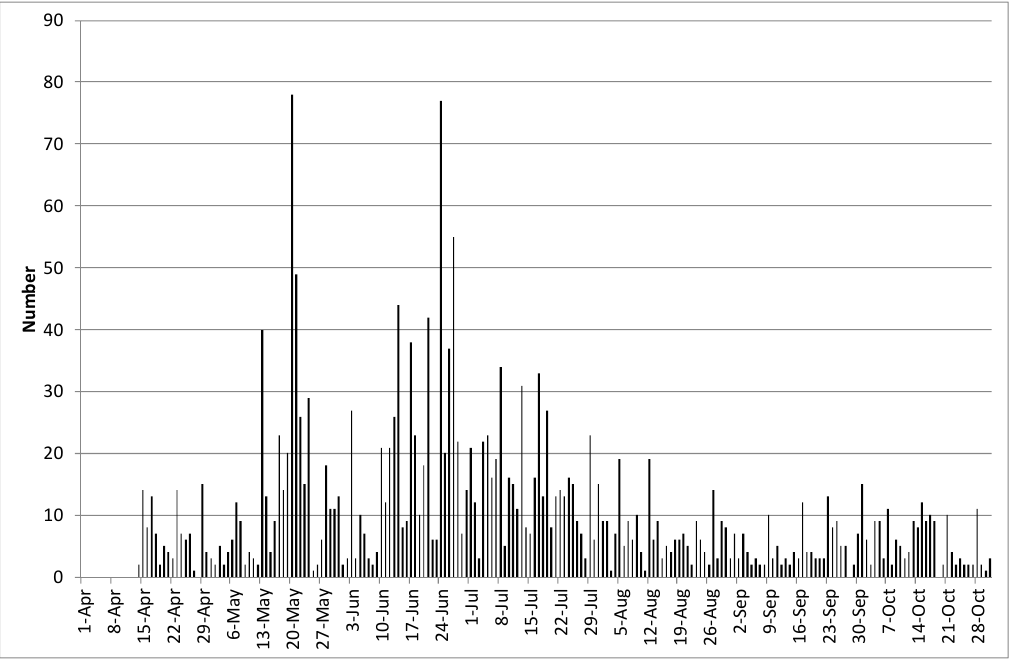
Figure 8. The number of visits in 2019 to the web page summarising daily information on sightings by citizen scientists in northern Europe from 1 April until 30 September.